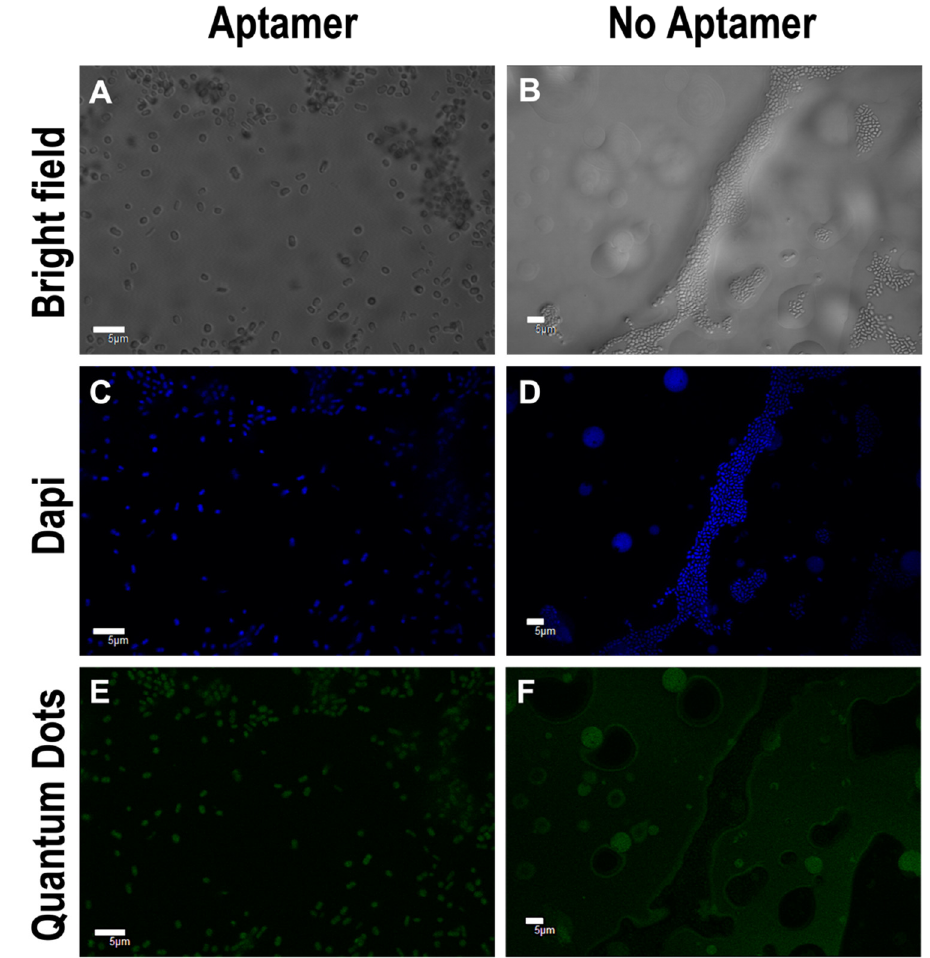
Figure 3. Confocal images of AB9 targeted with QDs-aptamer and QDs-MSA (No Aptamer). Images show cells under bright field ( A , B ), Dapi staining the cell’s RNA in blue channel ( C , D ), and QDs in the green channel ( E , F ). Scale-bar is 5 µ m. Dapi λ ex = 405 nm, QDs λ ex = 473